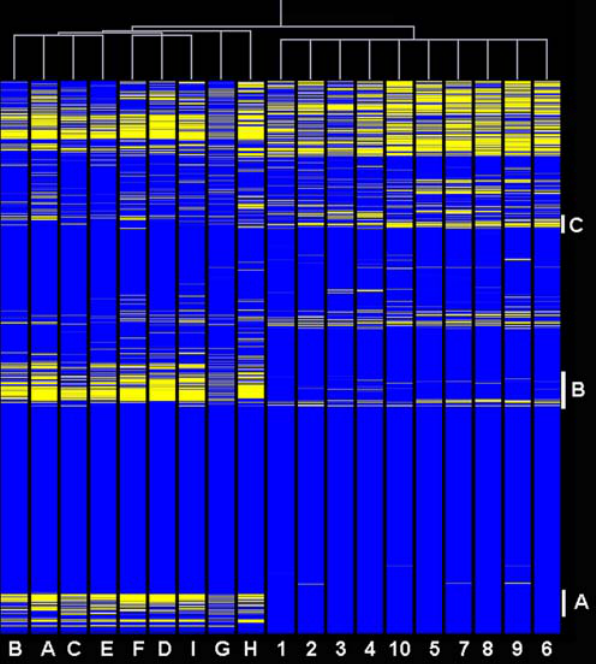
Figure 2. Two-way clustering analysis of R.conorii transcrip- tomic patterns. The figure shows a clear separation of two clusters containing 8 eschars recovered from different infectious episodes and 10 slides corresponding to bacteria grown in Vero cells and used as control, respectively. Each probe set is represented by a single row of colored boxes and each sample (eschar or control) correspond to a single column. The blue areas correspond to genes showing high or medium expression whereas yellow bars indicates genes poorly or not expressed. The dendrogram (white lines) on the top of the figure represents the similarity matrix of probe sets. Among clusters of genes allowing discriminating between the 2 tested conditions, A contains 70 genes involved mainly in different metabolic functions (transporters, DNA repair enzyme mutL , metabolic enzymes and numerous ribosomal proteins), cluster B contains an important number of genes involved in energy production (ATP synthesis) as well as genes involved in stress- response ( uvrA and C and htpG ), cell division and some virulence factors ( virB4 and virB10 ) and antibiotic resistance determinants. Cluster C contains several hem